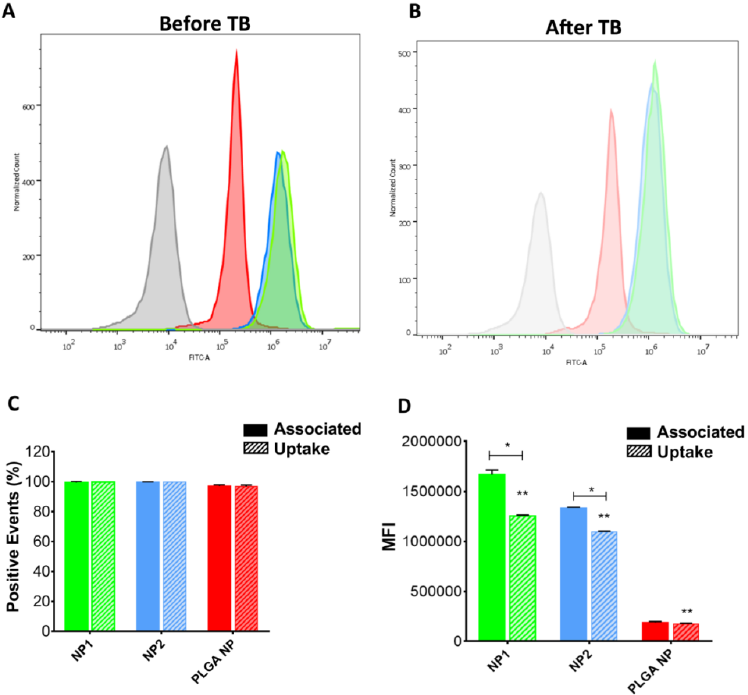
Figure 8. Cytofluorometric analysis. Histograms of association studies between HUVEC and NPs before ( A ) and after ( B ) extracellular fluorescence quenching with trypan blue (TB) by flow cytometry. Control (untreated cells) is represented in grey. ( C ) quantitative determination of cell–NP association and uptake. ( D ) Mean fluorescence intensity (MFI) analysis of extracellular binding and cellular uptake of NPs. Significant differences are indicated with * ( p < 0.005); **significant difference between each other.